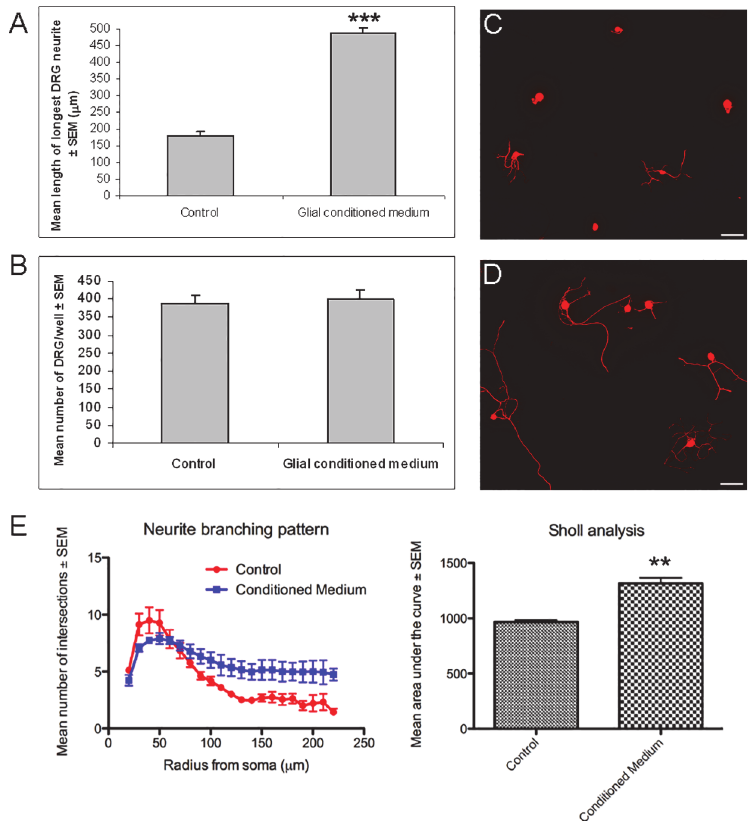
Results consist of the means ( ± SEM) of 4 separate experiments. Photomicrographs of either (C) untreated DRG or (D) retinal glial conditioned medium treated DRG. (E) Neurite branching of adult rat DRG is significantly increased when cells are cultured in glial conditioned medium. Results consist of the means ( ± SEM) of 3 separate experiments. Significant differences are indicated by asterisk (P < 0.01 = ** , P < 0.001 = *** ). Adult rat DRG were cultured for 2 days. Scale bars: 100 μ